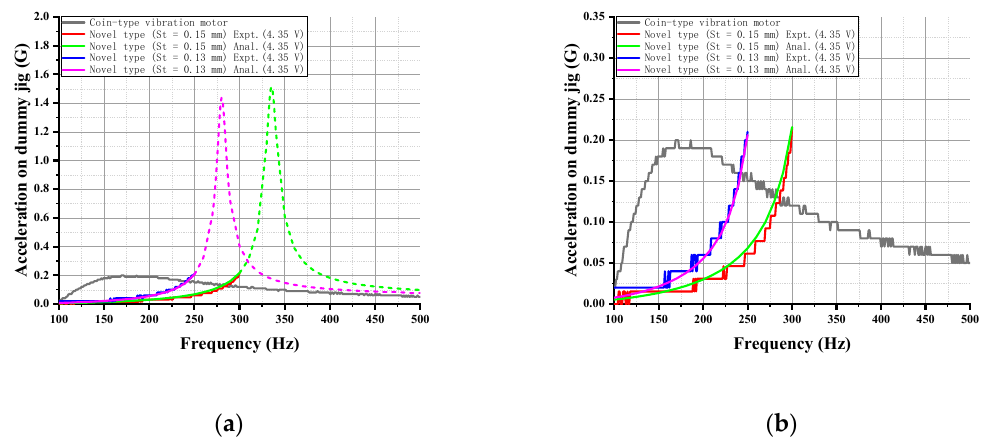
Figure 28. Acceleration comparison between coin-type vibration motor and novel linear vibration motors (4.35 V): ( a ) Acceleration from 100 to 500 Hz, ( b ) acceleration from 100 to 300 Hz. Table 11. Specifications of the coin-type vibration motor and novel linear vibration motor. Items Coin-Type Vibration